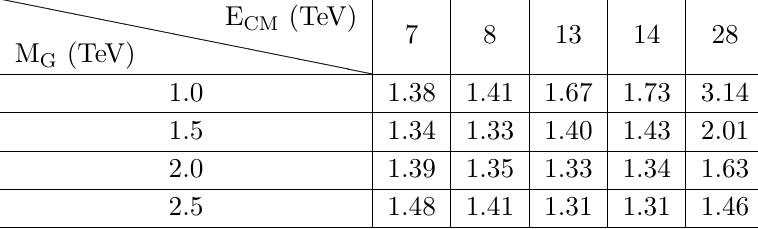
Table 2 . K-factor ( R 20 ) for different collider energies at select resonance masses for ( k q , k g ) = (1 . 0 , 0 . 1)